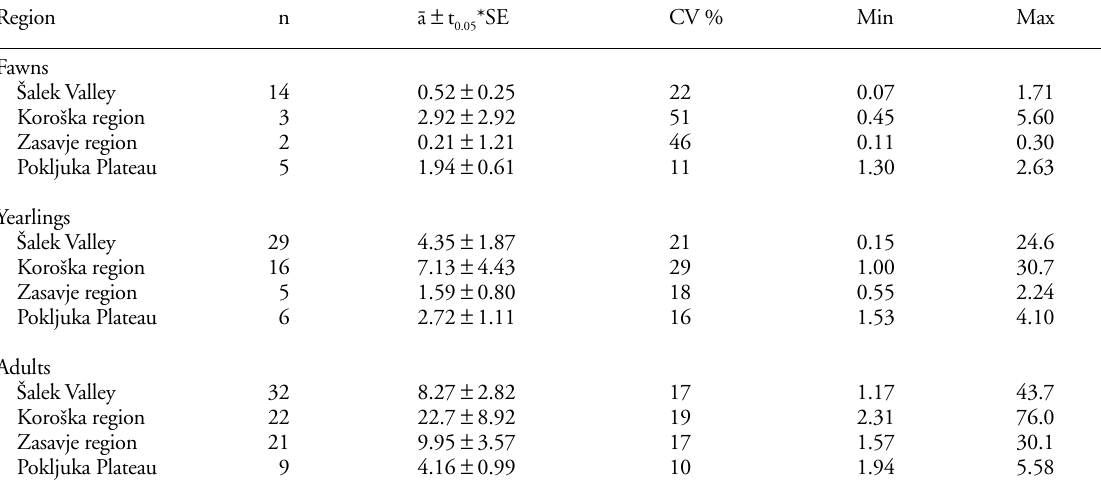
Table 1. Levels of Cd (mg kg –1 wet weight) in kidneys of roe deer shot in some Slovenian regions in 1997. The arithmetic means ( ā ) with the 95% confidence intervals, coefficient of variation (CV %) and range (Min, Max) are given. Region n ā ± t 0.05